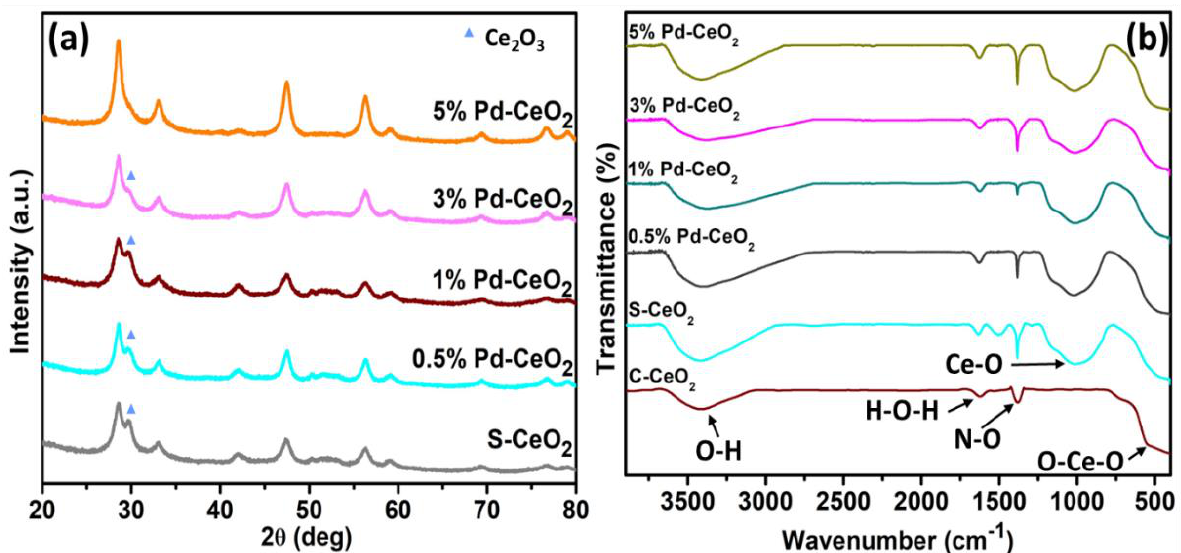
Figure 1. ( a ) XRD patterns and ( b ) FTIR-spectra of S − CeO 2 and (0.5, 1, 3, and 5%) Pd − CeO 2 NPs.